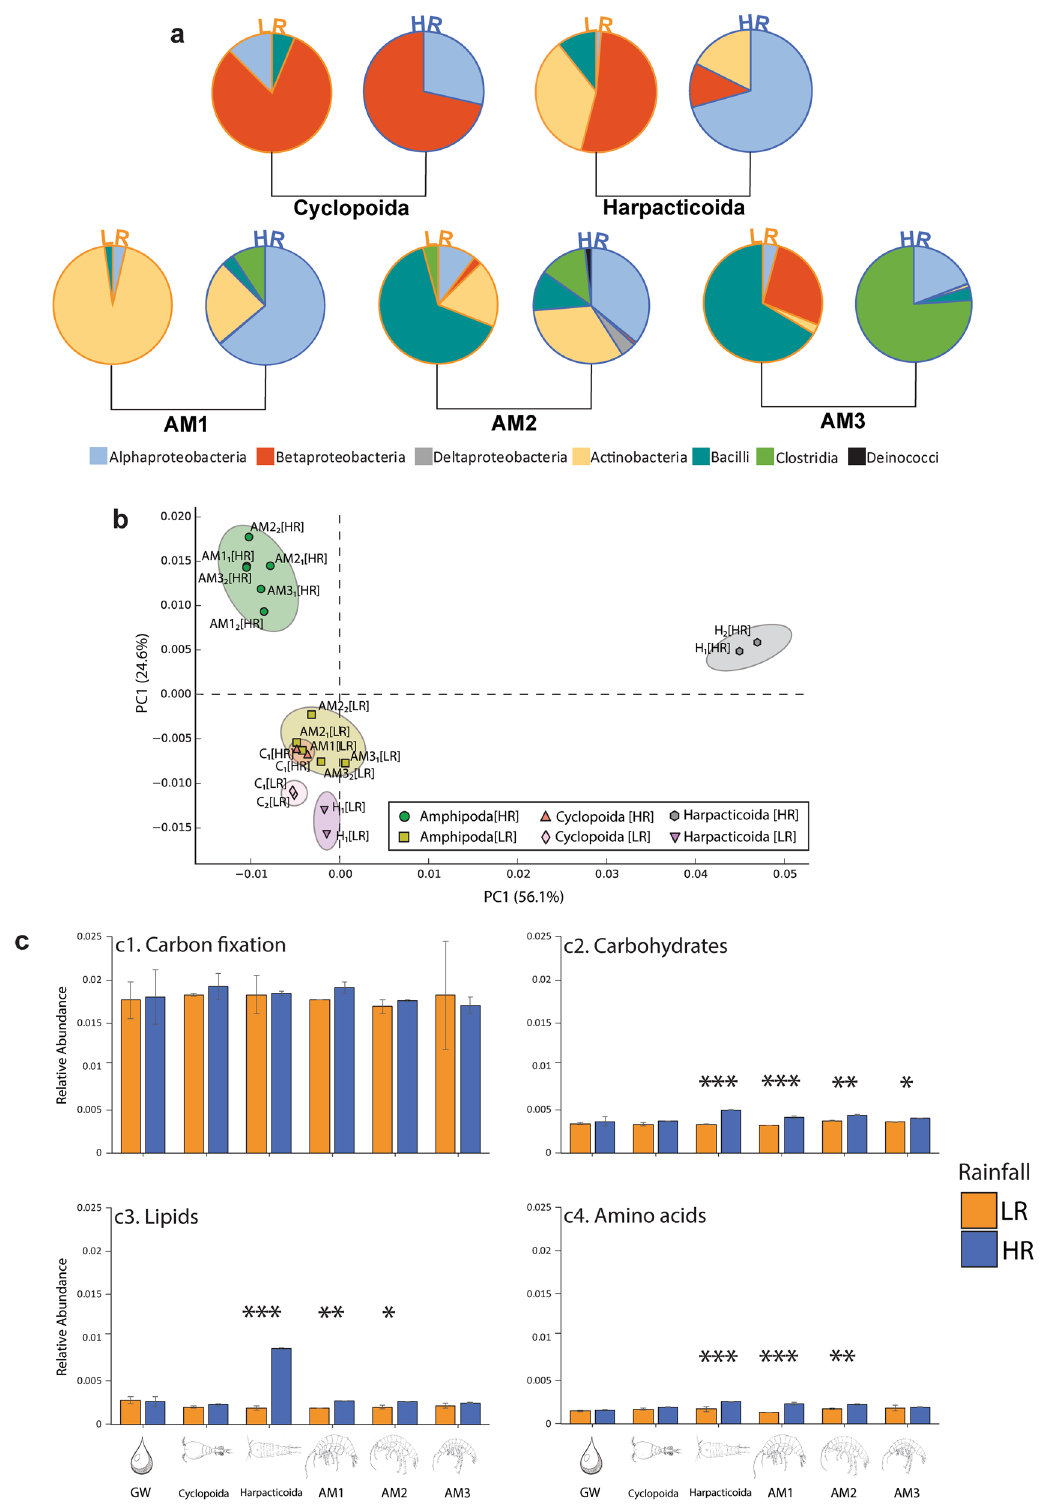
Figure 2. Microbial gut diversity and functional genomic results. ( a ) Relative abundances (in %) of the classes found in copepods (cyclopoids and harpacticoids) and amphipods AM1, AM2 and AM3 under LR (low rainfall) and HR (high rainfall). ( b ) PCA-based ordination analysis illustrating the distribution of taxa across rainfall periods (LR and HR) according to the KEGG orthologs metabolic functions. ( c ) Abundances of the major KEGG pathways associated with carbon metabolism (c1), carbohydrates metabolism (c2), lipids metabolism (c3) and amino acids metabolism (c4). * P < 0.05; ** P < 0.005; *** P <